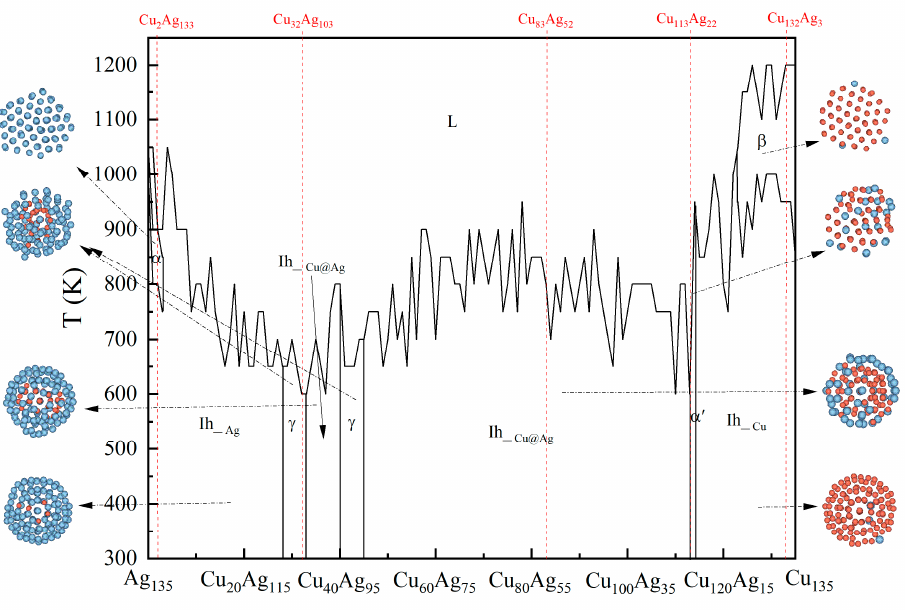
Figure 1. Structural diagram for Cu n Ag 135-n nanoalloy.